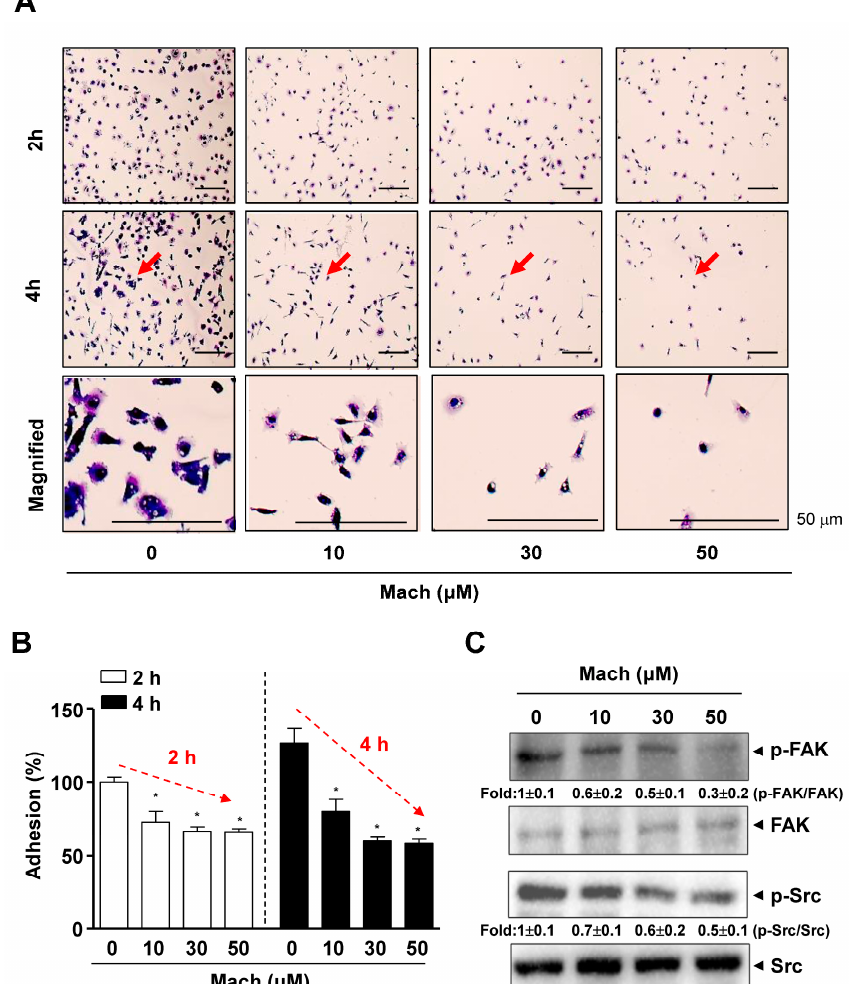
Figure 2. Effects of Mach on cell adhesion and Fyn/Src signaling in human YD-10B OSCC cells. ( A , B ) Cell adhesion on ECM-coated plates was observed after treatment with Mach for 2 and 4 h using a light microscope. The magnified regions are indicated by arrows. Scale bar: 50 µ m ( A ). Relative adhesion is shown as a bar graph ( B ). ( C ) Western blotting of phospho-FAK (p-FAK), FAK, phospho- Src (p-Src), and Src levels. Data are the mean ± SEM. Statistical significance was analyzed using Student’s unpaired t -test. Asterisks indicate statistical significance (* p <